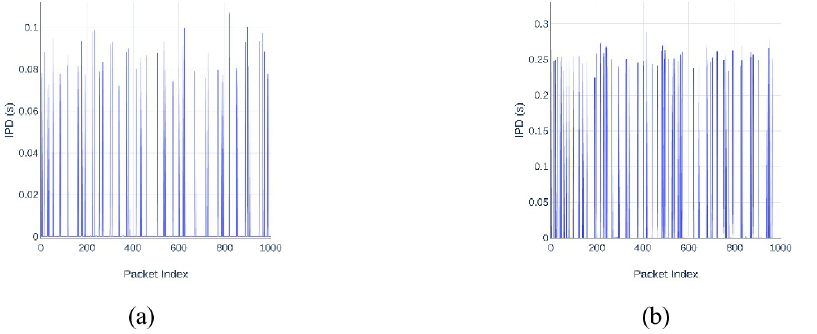
Fig 3. IPDs of Cloak link. (a) Cloak 5 (64,4). (b) Cloak 8 (64,4) .